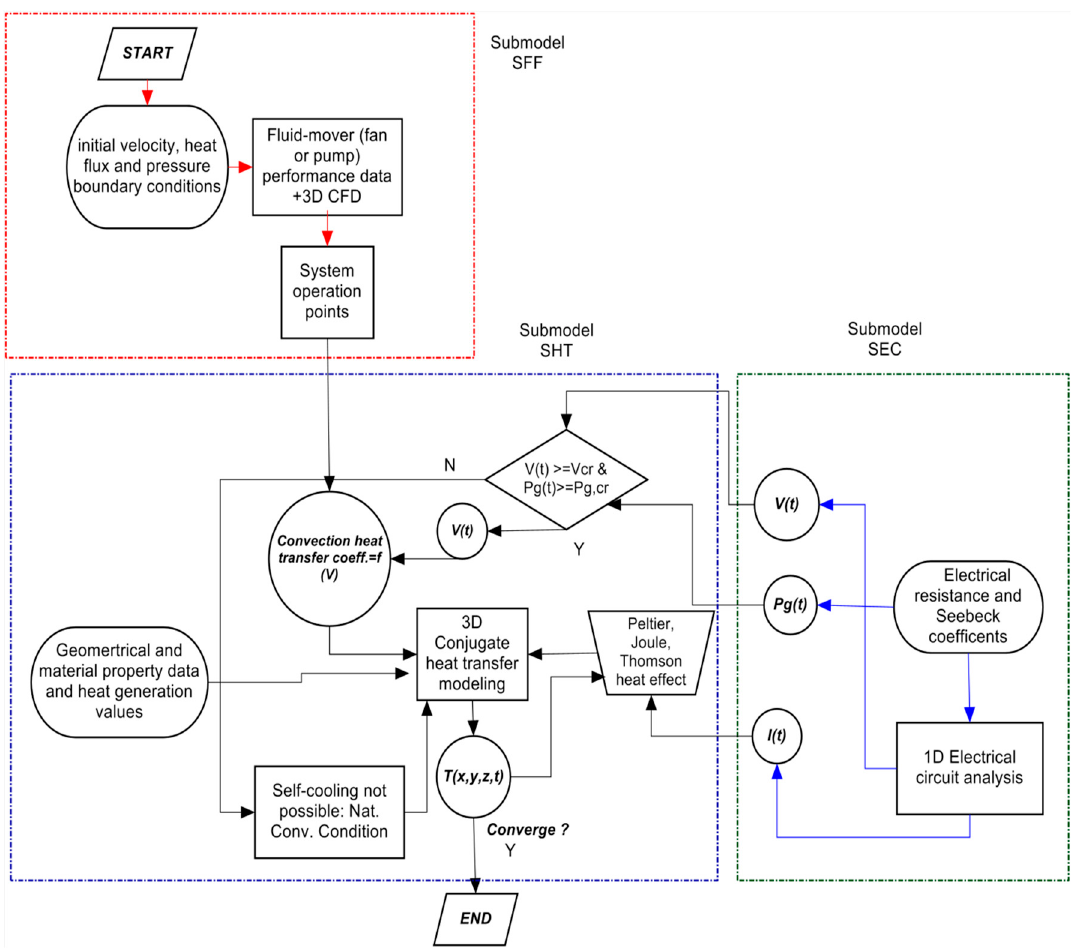
Figure 2. Numerical methodology.